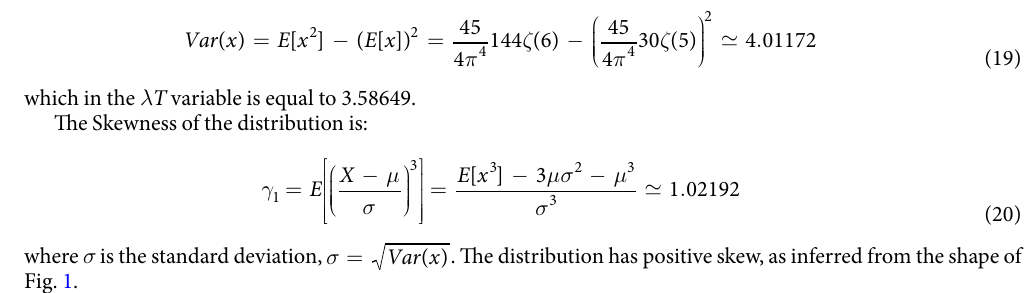
which in the λ T variable is equal to 3.58649.